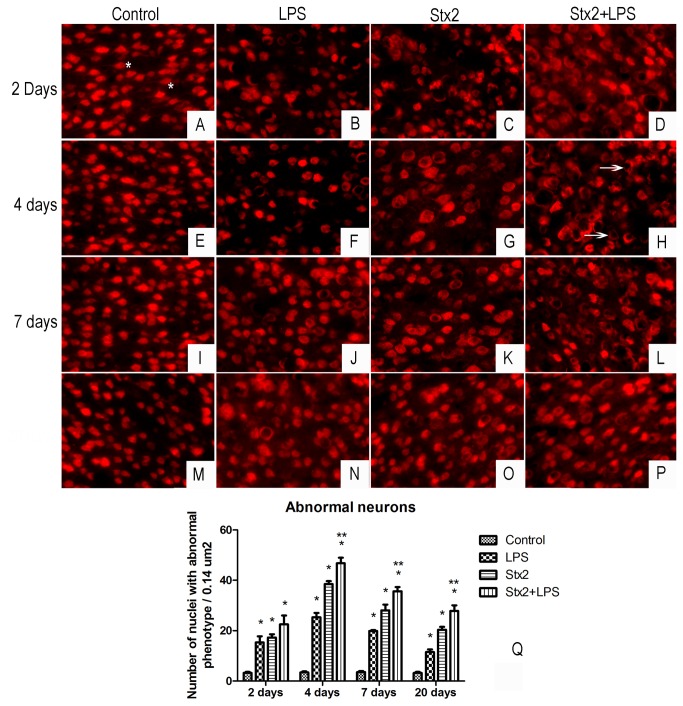
Changes in the expression of NeuN.Micrographs show immunofluorescence staining for NeuN in the nucleus of neurons in the motor cortex labeled with anti-NeuN. A, E, I and M: vehicle; B, F, J and N: LPS; C, G, K and O: Stx2; D, H, L and P: Stx2+LPS; at two, four, seven and twenty days after the respective treatment. Arrows show nuclei of degenerating neurons (H); asterisk shows normal nuclei of neurons (A). Quantification of phenotypic nuclear abnormalities in neurons at different days and for different treatments (Q). *: significant differences among all treated and control groups, ** significant differences between Stx2 and Stx2+LPS treatments (p <0.001).